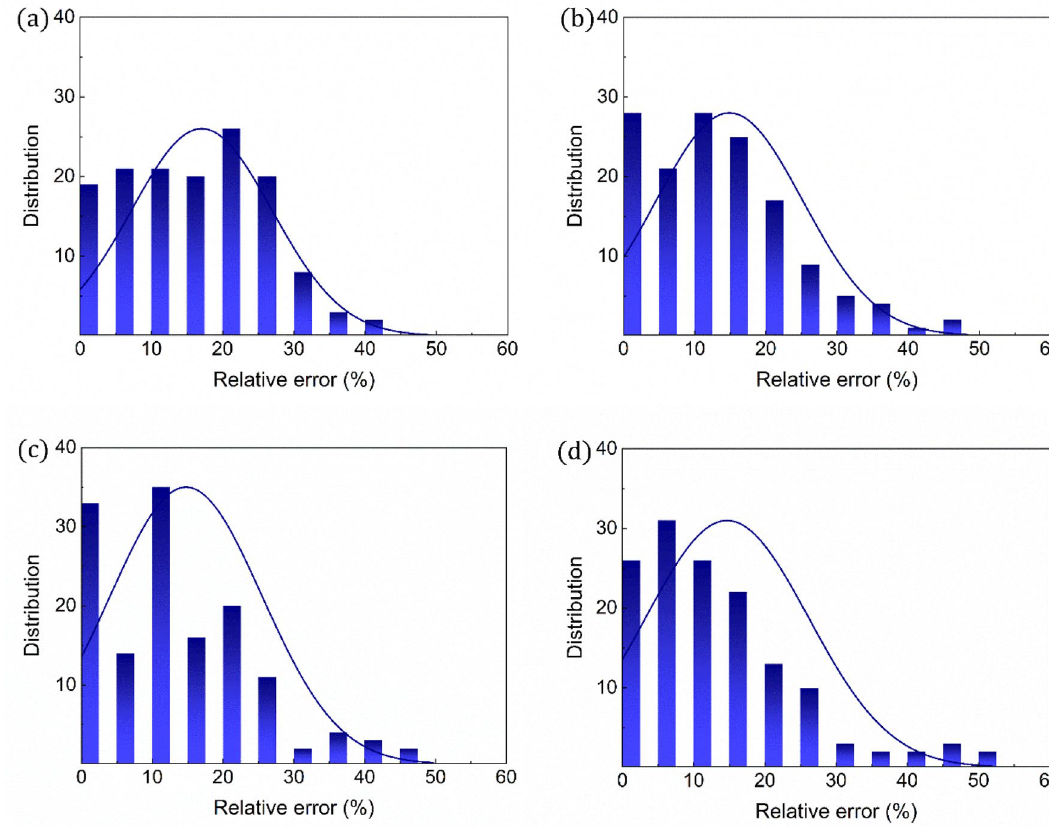
Figure 9. Relative errors for dielectric strength. Errors of the equation-predicted dielectric strengths relative to their experimental values. The coefficients of the equations are parameterized for the equation-based prediction of the experimental values of either ( a ) 30, ( b ) 60, ( c ) 90 or ( d ) all the compounds in Fig. S3 in the Supporting Information. The equations are correlated with polarizability, ionization energy, and molecular